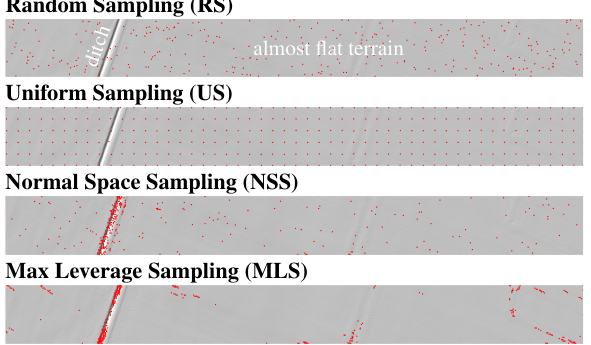
Figure 4: Comparison of correspondence selection strategies (from Glira et al. (2015)). Each strategy was applied to select approximately 300 points. A shaded Digital Elevation Model (DEM) of the ALS scene is visualized in the background. Matching This step establishes the correspondences. For this, each selected point from the previous step is paired to the near- est neighbour (closest point) of the overlapping strip. As in the adjustment the point-to-plane distance is minimized for each cor- respondence, two associated points don’t have to be identical in object space, but they only have to belong to the same (tangent) plane (e.g. flat terrain surface). Due to the good initial orientation and the high point density in ALS, this requirement is mostly ful- filled. The nearest neighbour search can be realized efficiently using k-d trees.